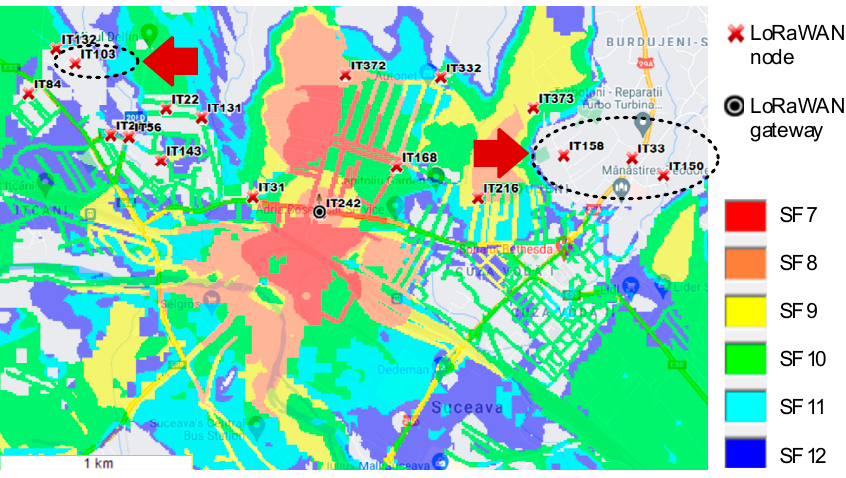
Figure 9. LoRaWAN Coverage Scenario 1.